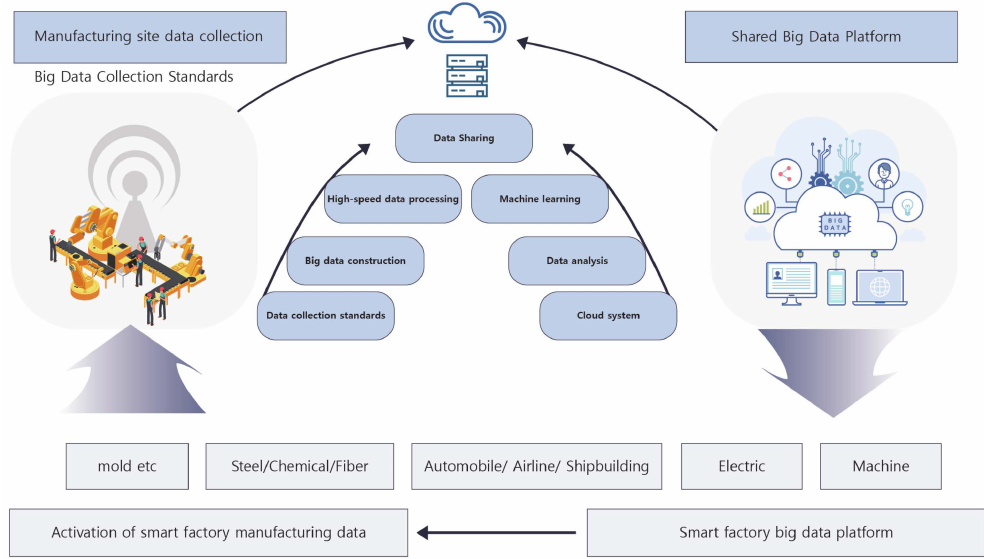
Figure 3. The structure of a cloud manufacturing